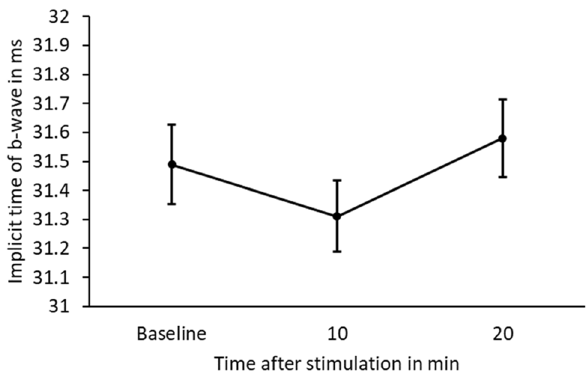
Figure 1. Mean and standard error of the mean (SEM) of implicit time of b-wave in ms for baseline and 10 and 20 min after blue light stimulation of the blind-spot in 10